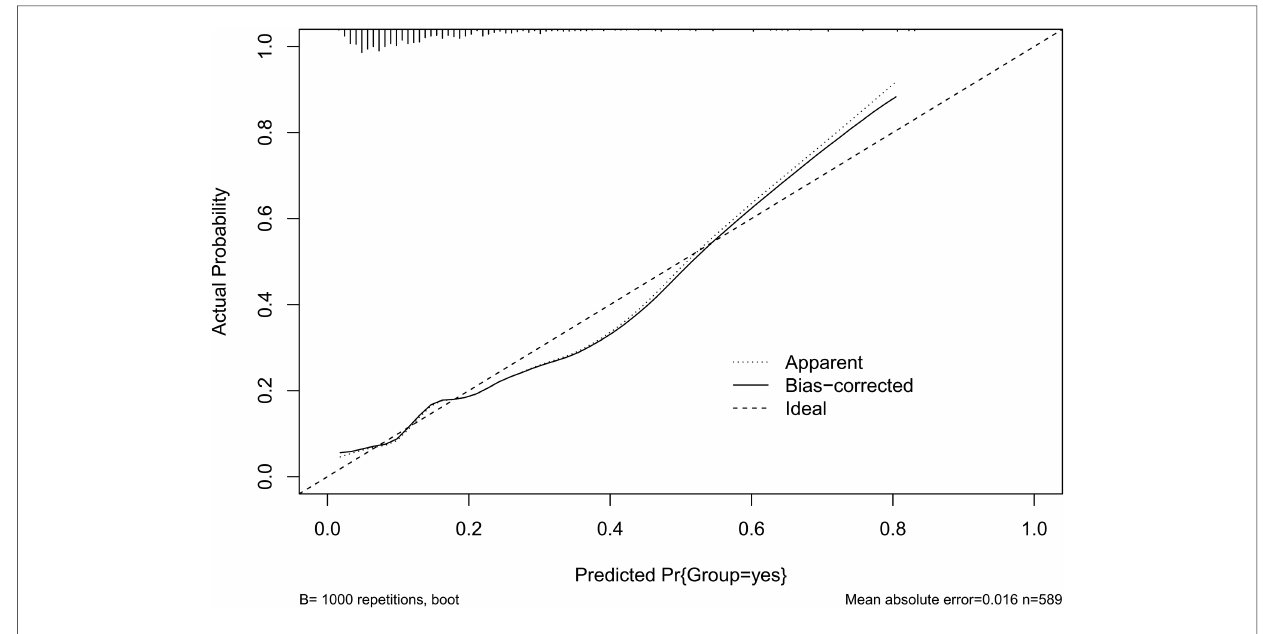
FIGURE 4 The calibration curve of POAF risk prediction